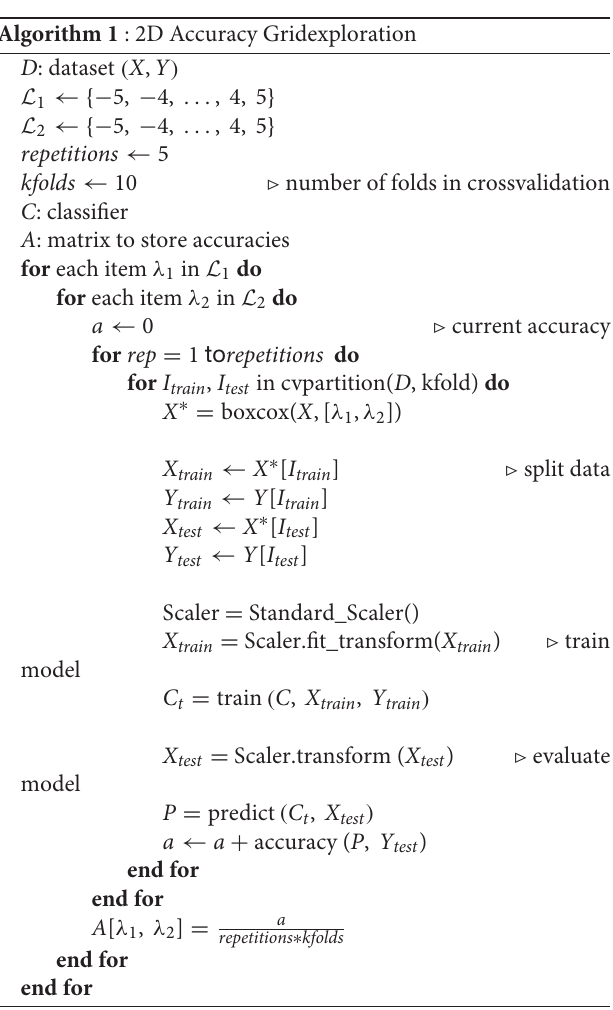
TABLE 3 | Average accuracy of five classifiers before and after applying Box-Cox transformation using three optimization strategies for 10 times regenerated random dataset Figure 1D with different random